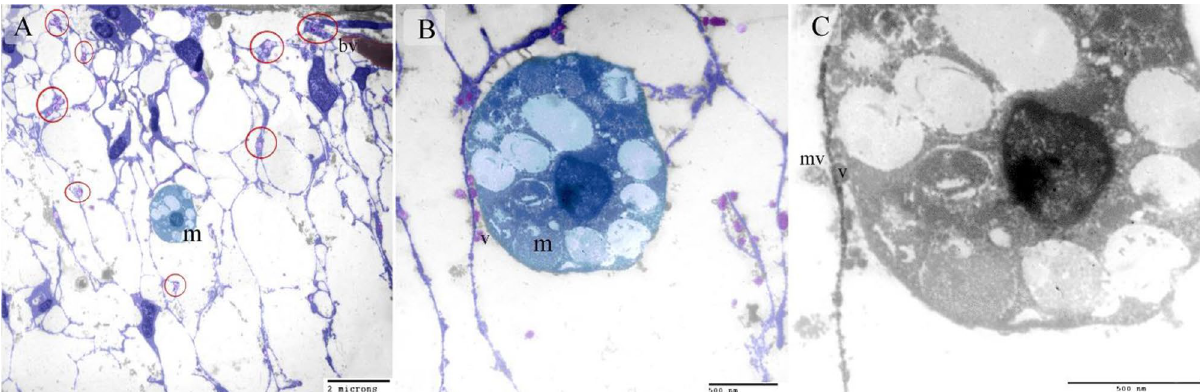
Figure 4. Identification of TCs using TEM. Ultrathin sections of the neck skin of day 8 quail embryos. ( A , B ) TCs (blue colored) identified by TPs and podoms (red circles). TCs formed an extensive 3D network. Note the TPs connected to the macrophage (m) and secretory vesicles (v). ( C ): physical contact was observed between TPs and macrophage (arrows) that had phagosomes (p) contained materials of different stages of digestion and lipid inclusions (l). Note secretory vesicles (v) and multivesicular body (mv).